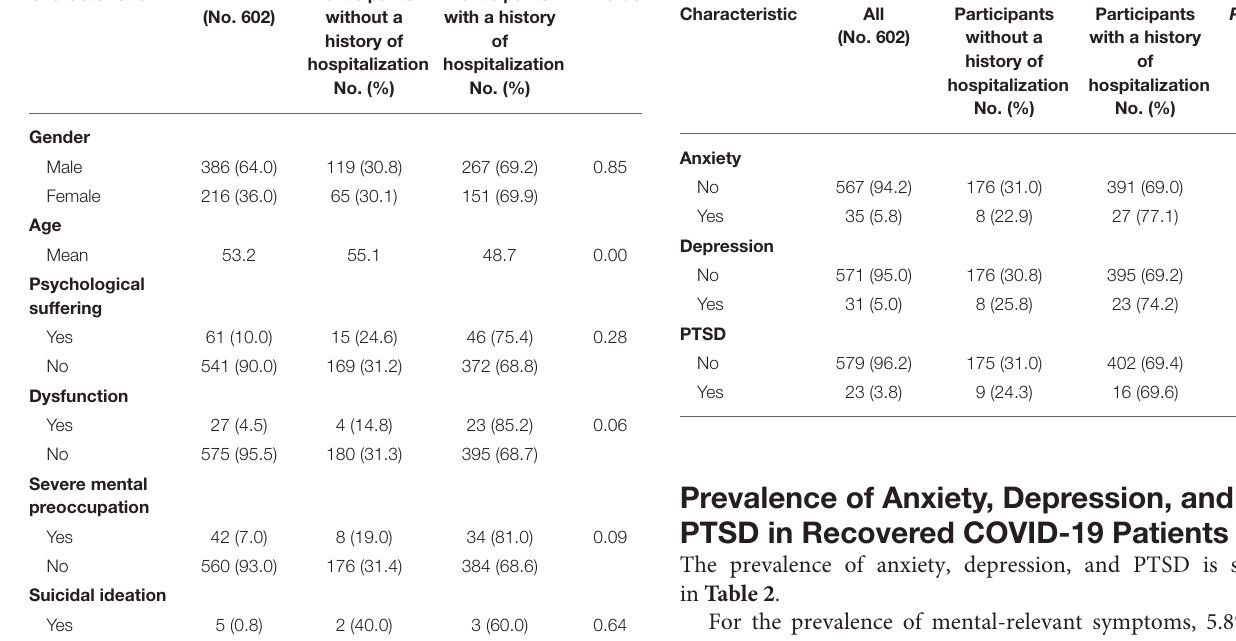
TABLE 2 | Characteristics of COVID-19 recovered patients anxiety, depression, and PTSD.